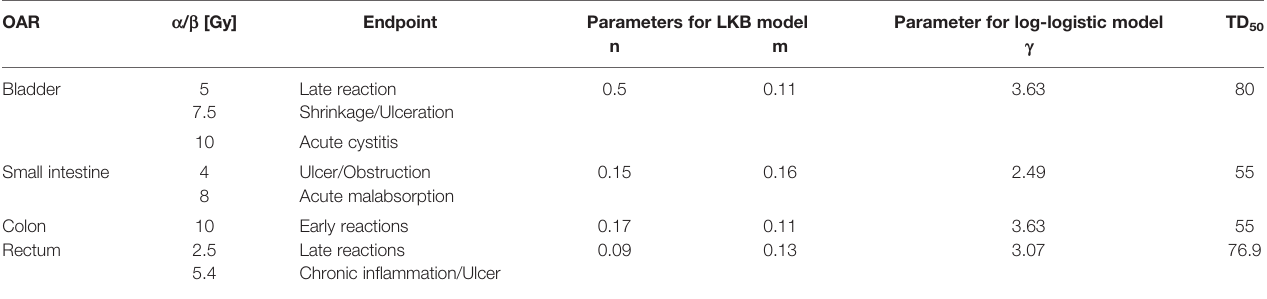
TABLE 3 | Radiobiological parameters to calculate equivalent uniform dose and normal tissue complication probabilities for the bladder and gastrointestinal tract at different endpoints and alpha – beta ratios. OAR a / b